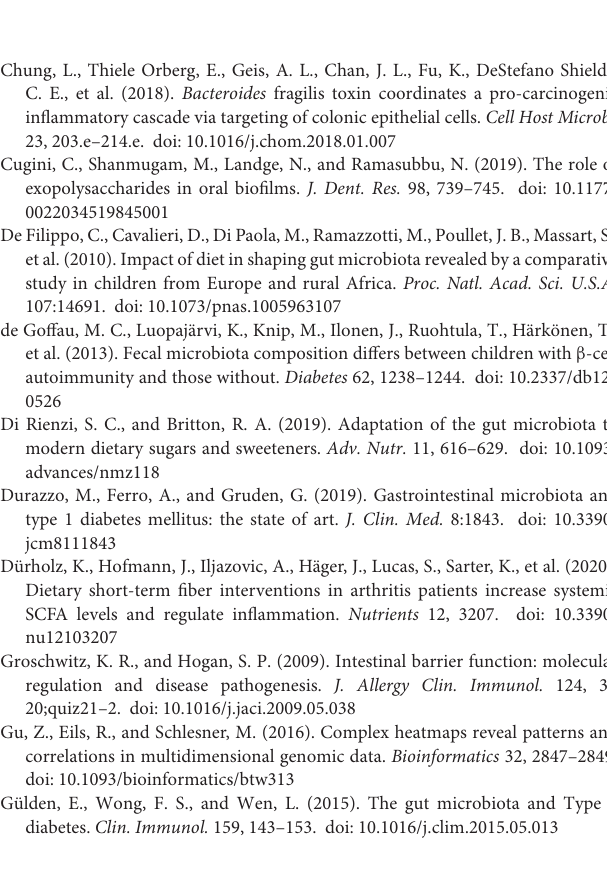
covering a broad carbohydrate range, resulting in a diverse symbiotic microbial metabolism. Supplementary Figure 3 | A heatmap of CAZyme family distribution in saliva (oral) and fecal (gut) samples of 935 metagenomes derived from healthy controls and patients with type 1 diabetes, colorectal cancer, and rheumatoid arthritis. A total of 27 distinct Carbohydrate-Binding Module (CBM), 13 Carbohydrate Esterase (CE), and 2 CAZymes performing Auxiliary Activity functions (AA) from nine phyla and 86 genera are represented. The oral and gut ecosystems show distinct profiles revealing a more extensive carbohydrate metabolism in the gut. CRC, colorectal cancer; T1db, type 1 diabetes; RArt, rheumatoid arthritis. The legend shows the Z scores of the mean log-transformed CAZyme family abundance. Supplementary Figure 4 | Supervised analysis and feature selection with sparse PLS-DA. With the disease status as a categorical variable, the loading weight of the most important CAZyme families selected on component 1 on which the sPLS-DA model was optimal was drawn. Fill colors indicate the disease status in which the CAZyme is most abundant. Supplementary Figure 5 | Relative abundance of the gut and oral microbial community faceted by disease phenotype at the (A) genus and (B) species level. The abbreviations are disease phenotypes, respectively; CRC, colorectal cancer; RArt, rheumatoid arthritis; T1db, type 1 diabetes. Relative abundance data are adapted from Schmidt et al. (2019). Supplementary Table 2 | CAZyme family gene copies per genome of the 310 strains used in this study together with their taxonomic ranks, the genome size (Sheet 1). Sheet 2 contains the CAZyme family abundances aggregated per metagenome and metagenome